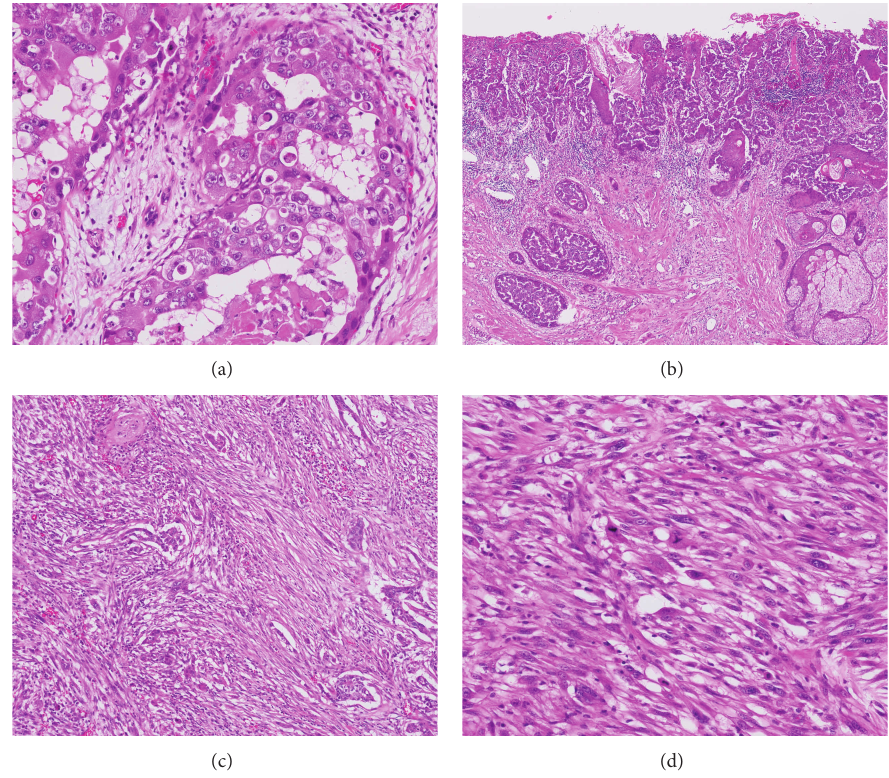
Figure 3: Histological features of apocrine and metaplastic carcinomas in the right breast. (a) HE. Apocrine carcinoma including intraductal components. (b) Intraepithelial invasion in nipple erosion had a Pagetoid appearance. (c) The apocrine carcinoma was admixed with the sarcomatoid spindle cell lesion. (d) The spindle cell lesion showed high nuclear polymorphism and atypia. Atypical mitotic figures are